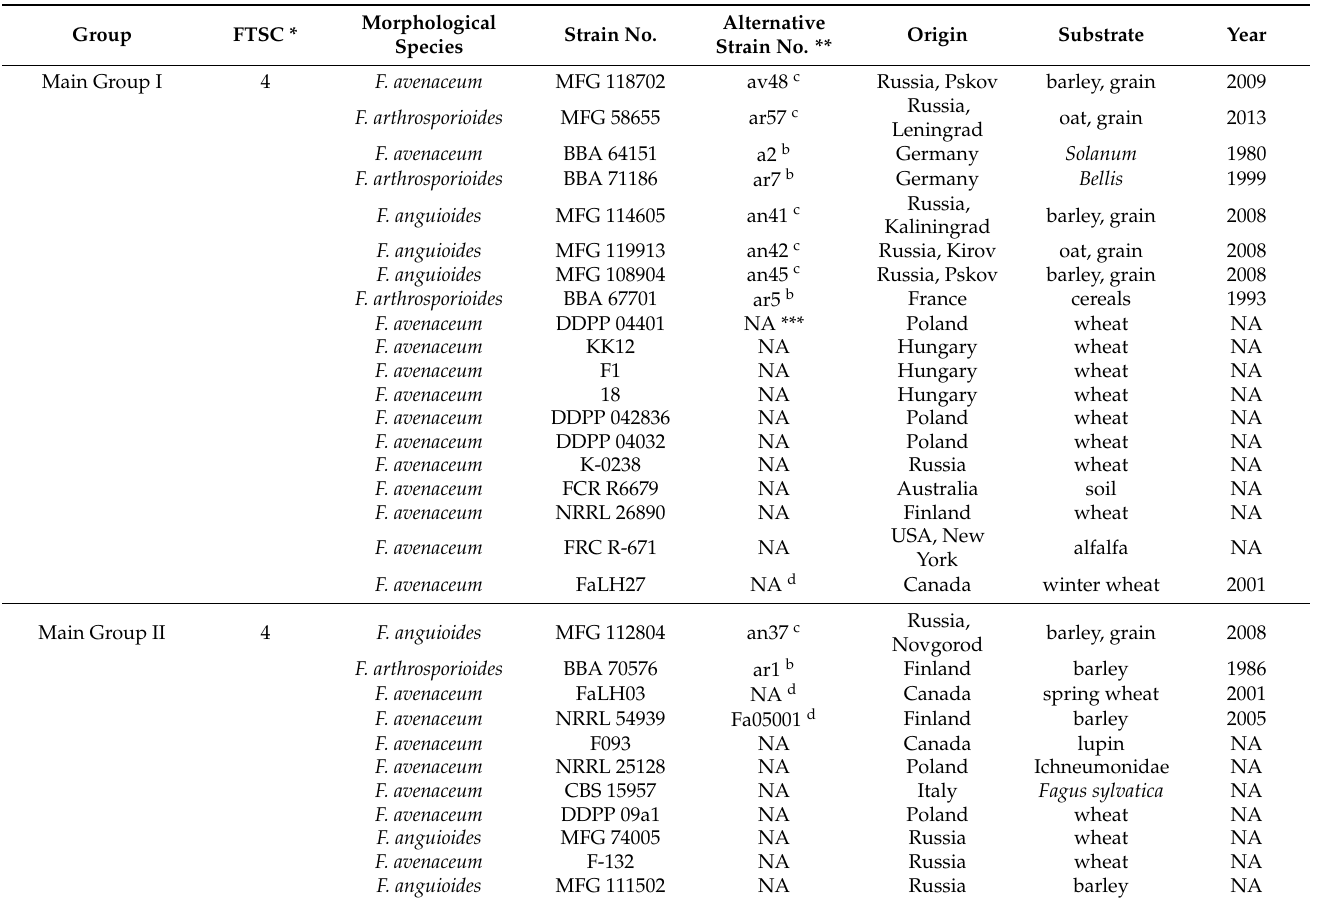
Table 1. Fusarium strains used in the present study and identified based on morphological and molecular